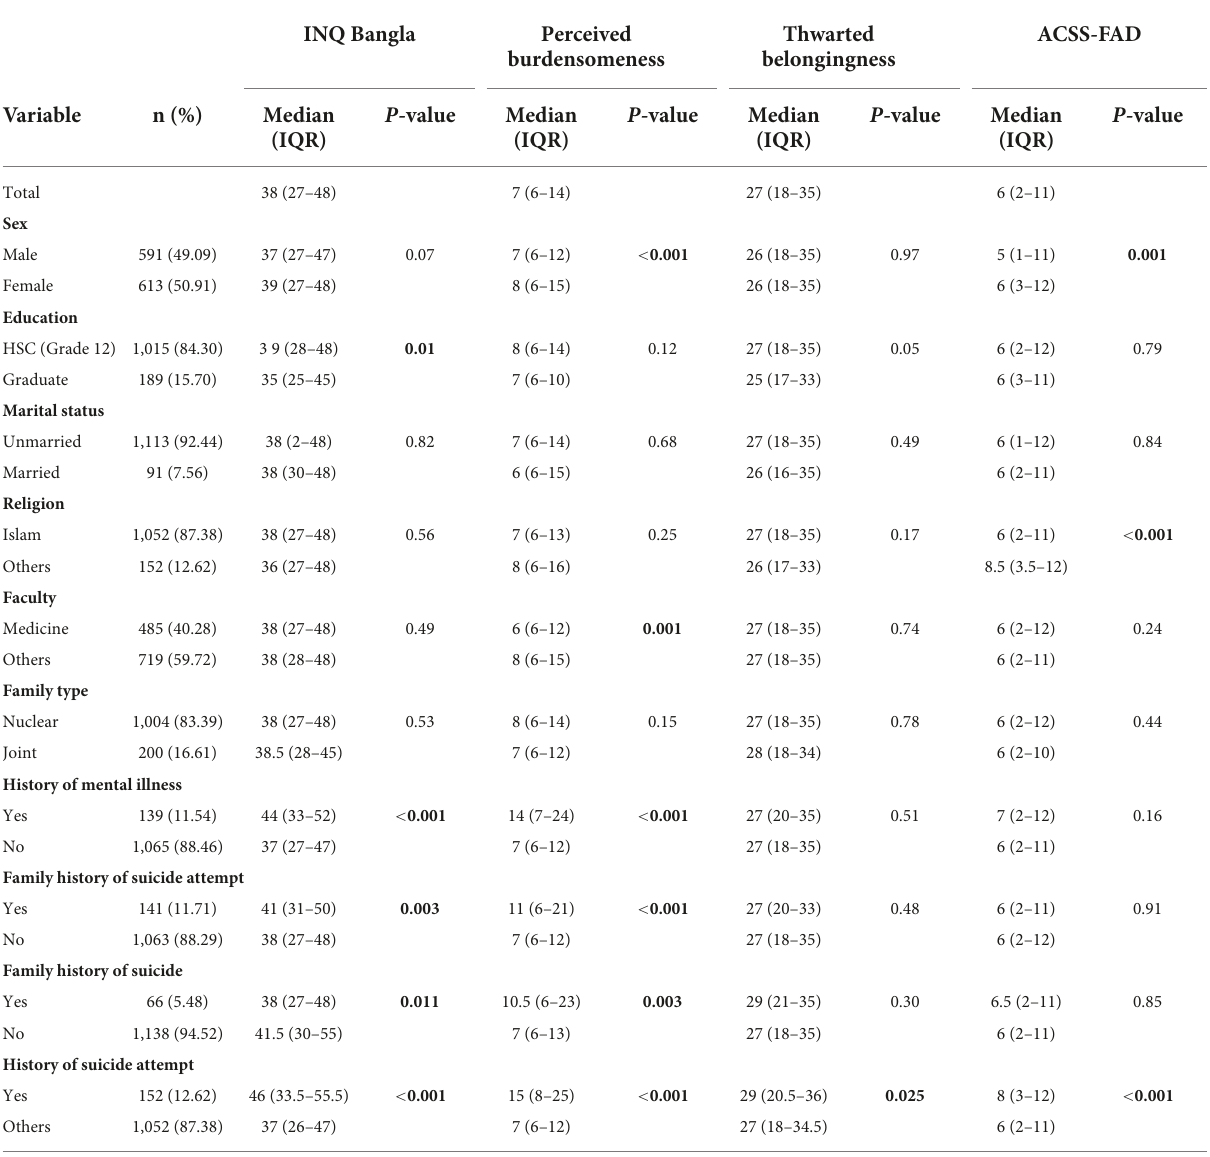
TABLE 5 Association between demography INQ-B and ACSS-FAD-B